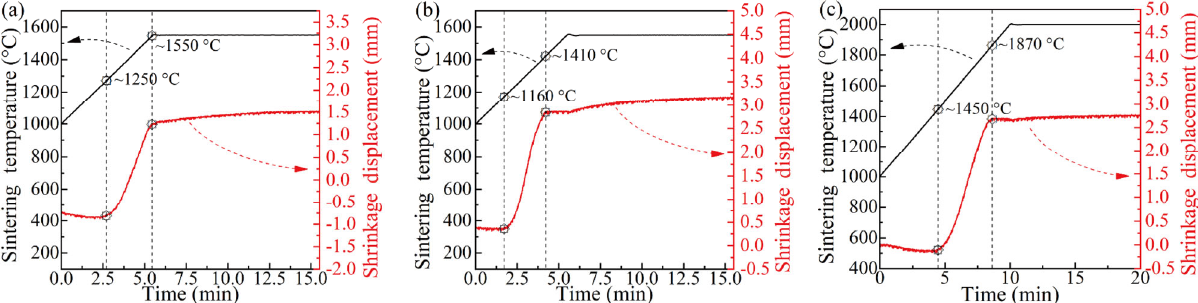
Fig. 3 Sintering temperature and shrinkage displacement curves of the ceramics during SPS: (a) HC1550-L, (b) HC1550-H, and (c) H2000.